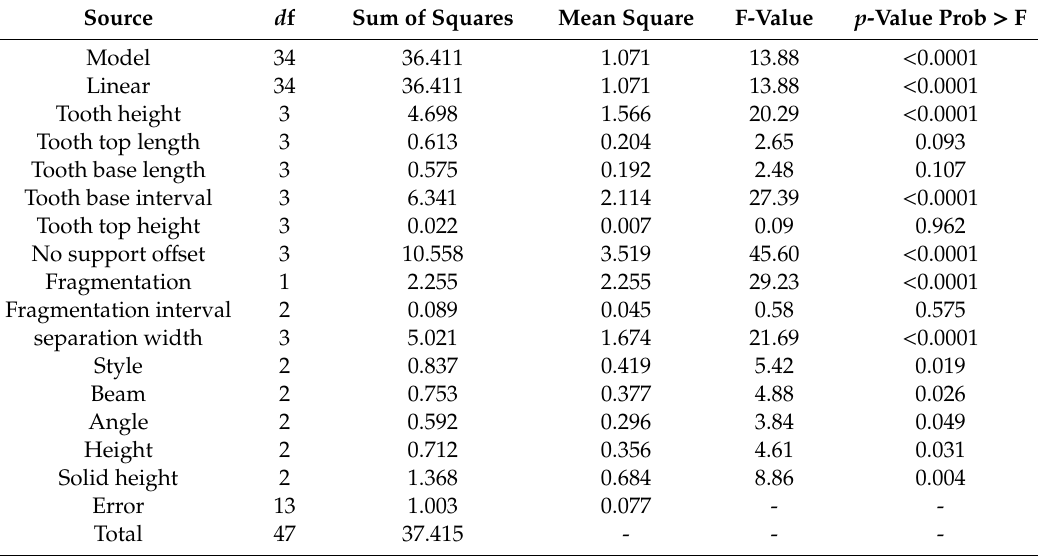
Table 2. ANOVA for support removability with respect to the support design parameter (hatching 6).